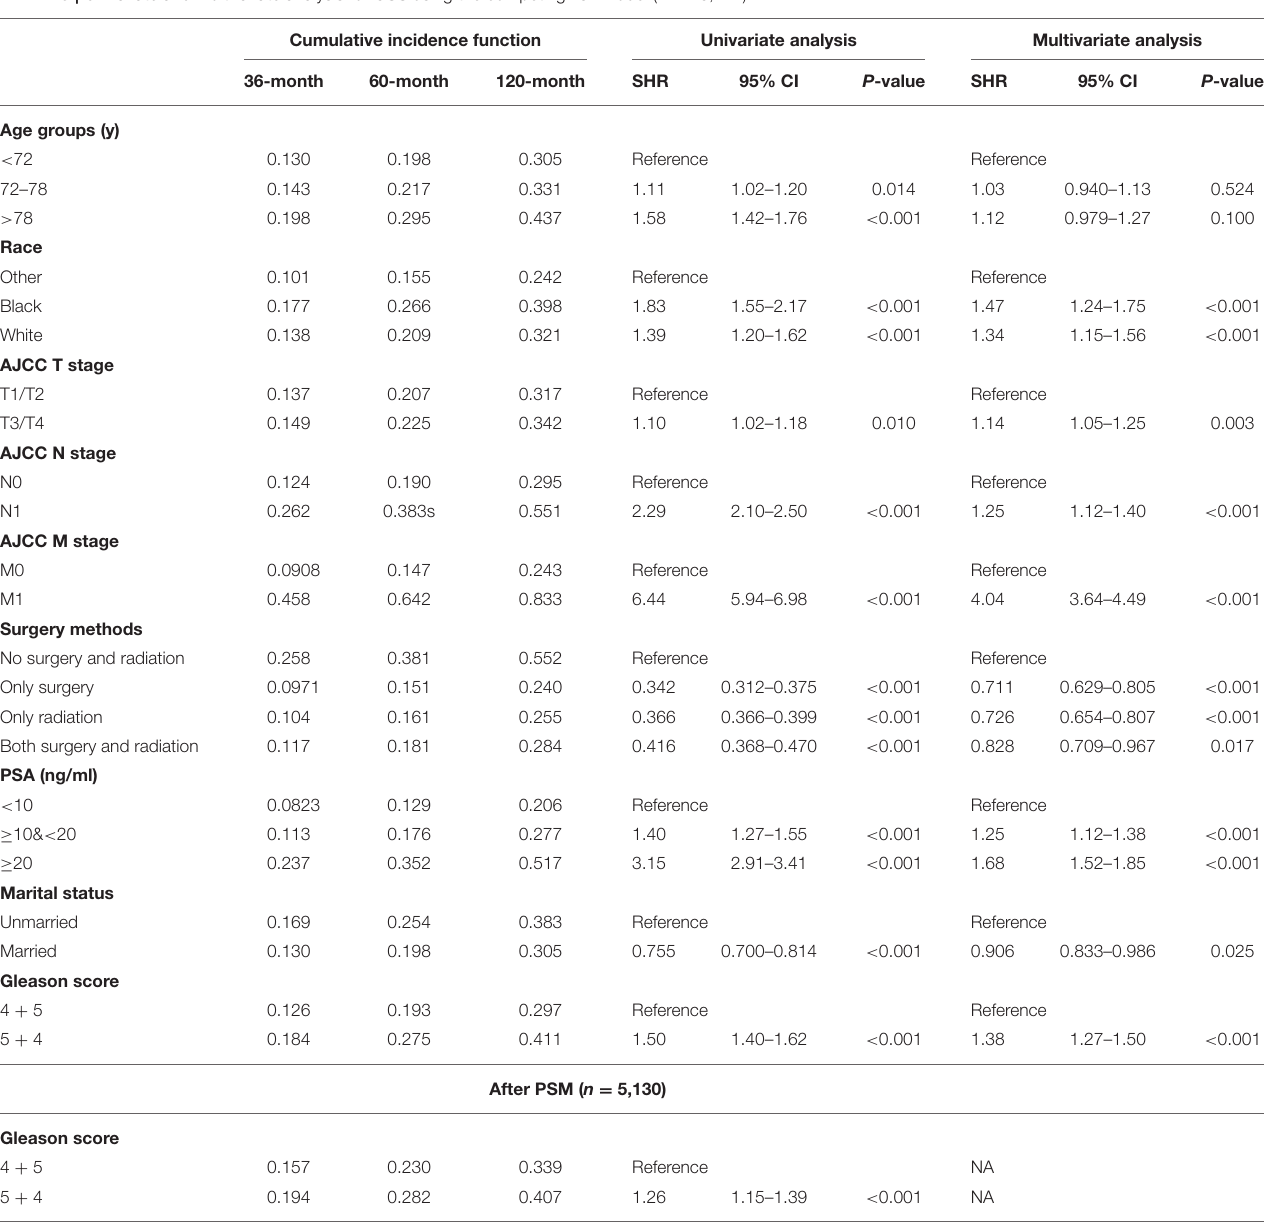
TABLE 3 | Univariate and multivariate analysis for CSS using the competing risk model ( n = 10,124). Cumulative incidence